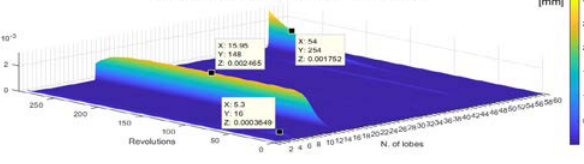
Fig. 10. WP geometry after 20 and 200 revolutions